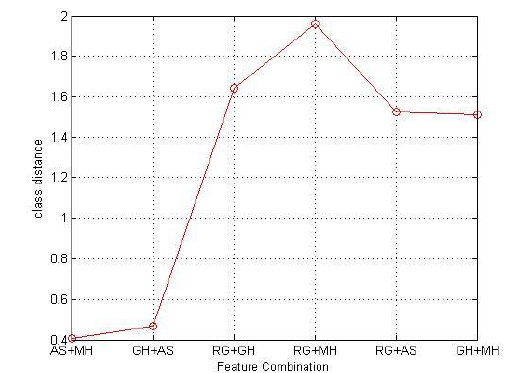
Figure 4. Class distance of different feature